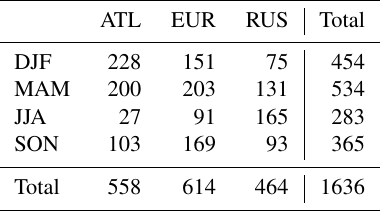
Figure 2. Longitudinal sectors considered for the identification of the centres of high-latitude blocks (northern black boxes) and sub- tropical ridges (southern black boxes): Atlantic (ATL, 30–0 ◦ W), European (EUR, 0–30 ◦ E) and Russian (RUS, 30–60 ◦ E, only par- tially shown). Grey boxes identify the geographic areas considered in the regional assessment performed in Sects. 3 and 4. The re- gions considered, from west to east and from north to south, are “UK/North Fr”, “Central/North EU”, “NE Scandinavia”, “Iberia”, “Central/South EU” and “East EU”.